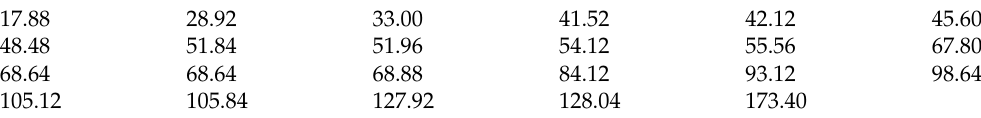
Figure 1. The quantile-to-quantile plot based on the complete sample of Example 1. Table 3. The endurance life of deep groove ball bearings (in million revolutions) will fail to